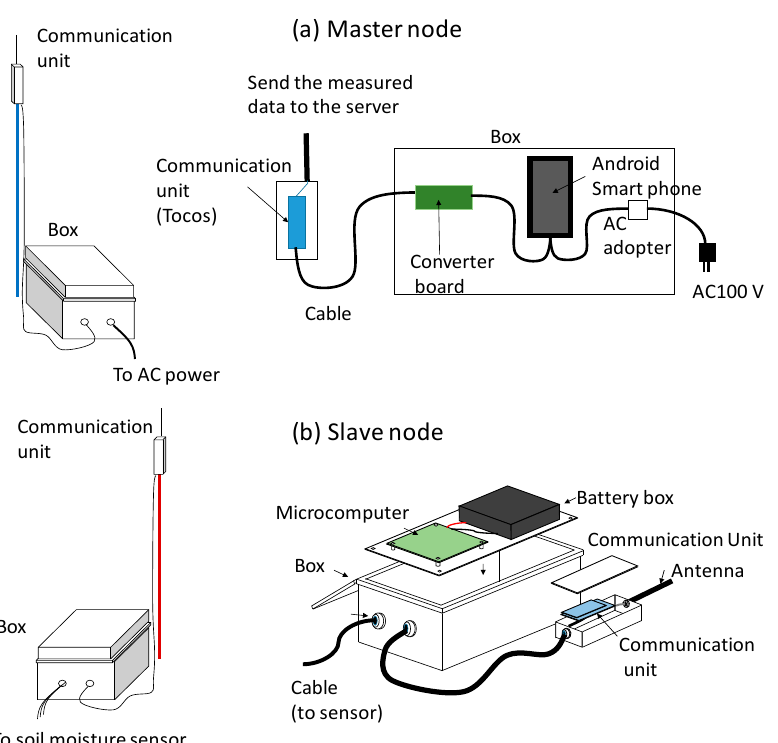
Figure 4. Details of ( a ) master node and ( b ) slave node of the sensor network system.